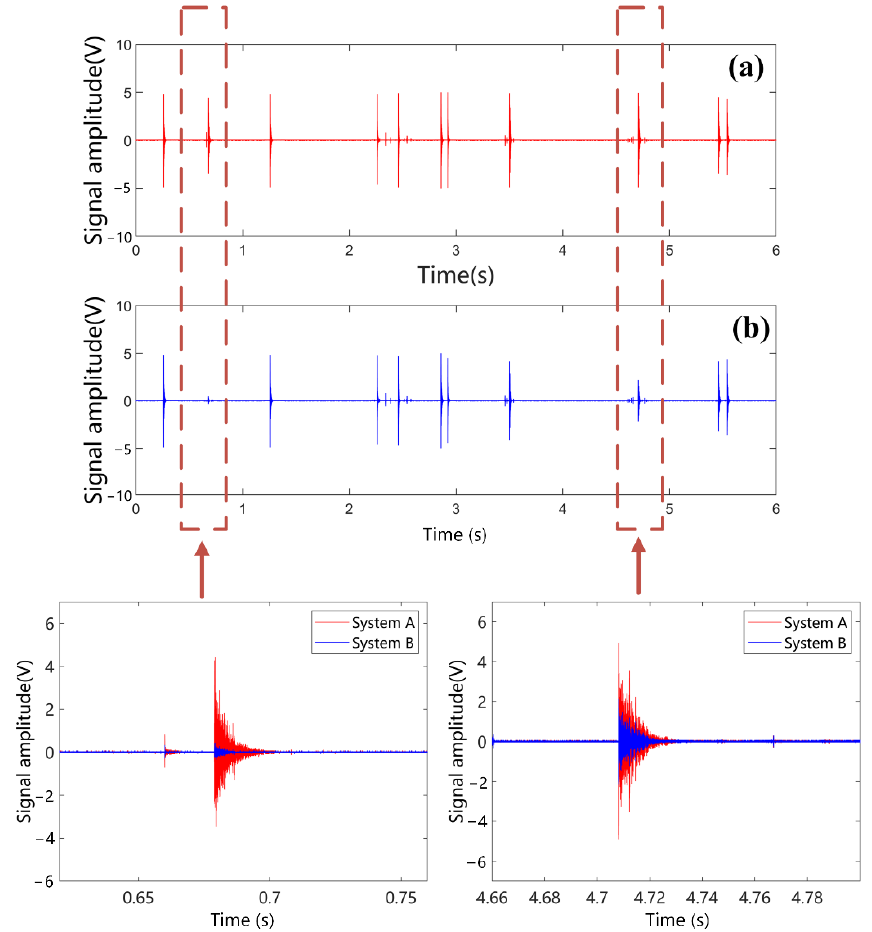
Figure 12. Measurement results of different systems: ( a ) sensing system A (after improvement) ( b ) sensing system B (before improvement).